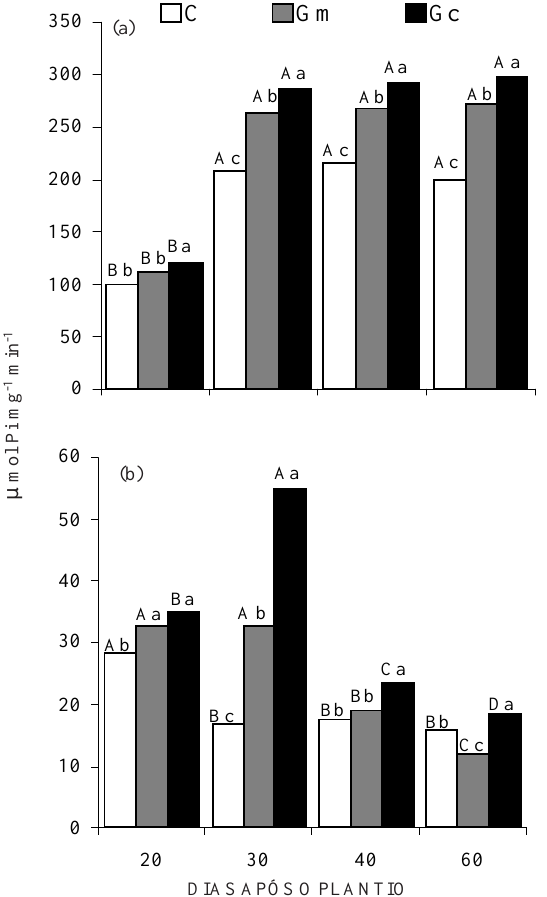
Figura 2. Atividade ATPásica (A) e Pirofosfatásica (B) em microssomos de raízes de milho não ino- culadas (Controle, C) ou inoculadas com Gigaspora margarita (Gm) ou Glomus clarum (Gc) aos 20, 30, 40 e 60 dias do plantio. As ativi- dades enzimáticas são expressas em ìmoles de Pi liberado por mg de proteína microssomal e por minuto de reação. Médias seguidas de mes- ma letra não diferem entre si pelo teste Tukey a 5 %. As barras com letras maiúsculas compa- ram as médias entre as épocas avaliadas num mesmo FMA, e as com minúsculas comparam médias entre os FMAs numa mesma